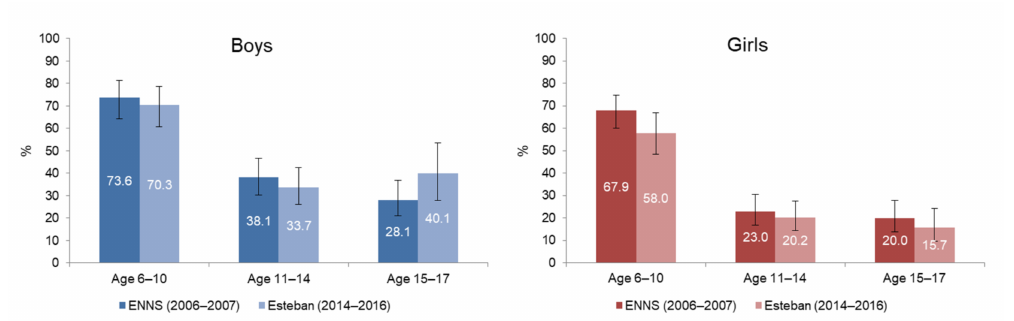
Figure 4. Prevalence of physical activity in boys and girls aged 6–17 years, between ENNS (2006–2007) and Esteban (2014–2016).